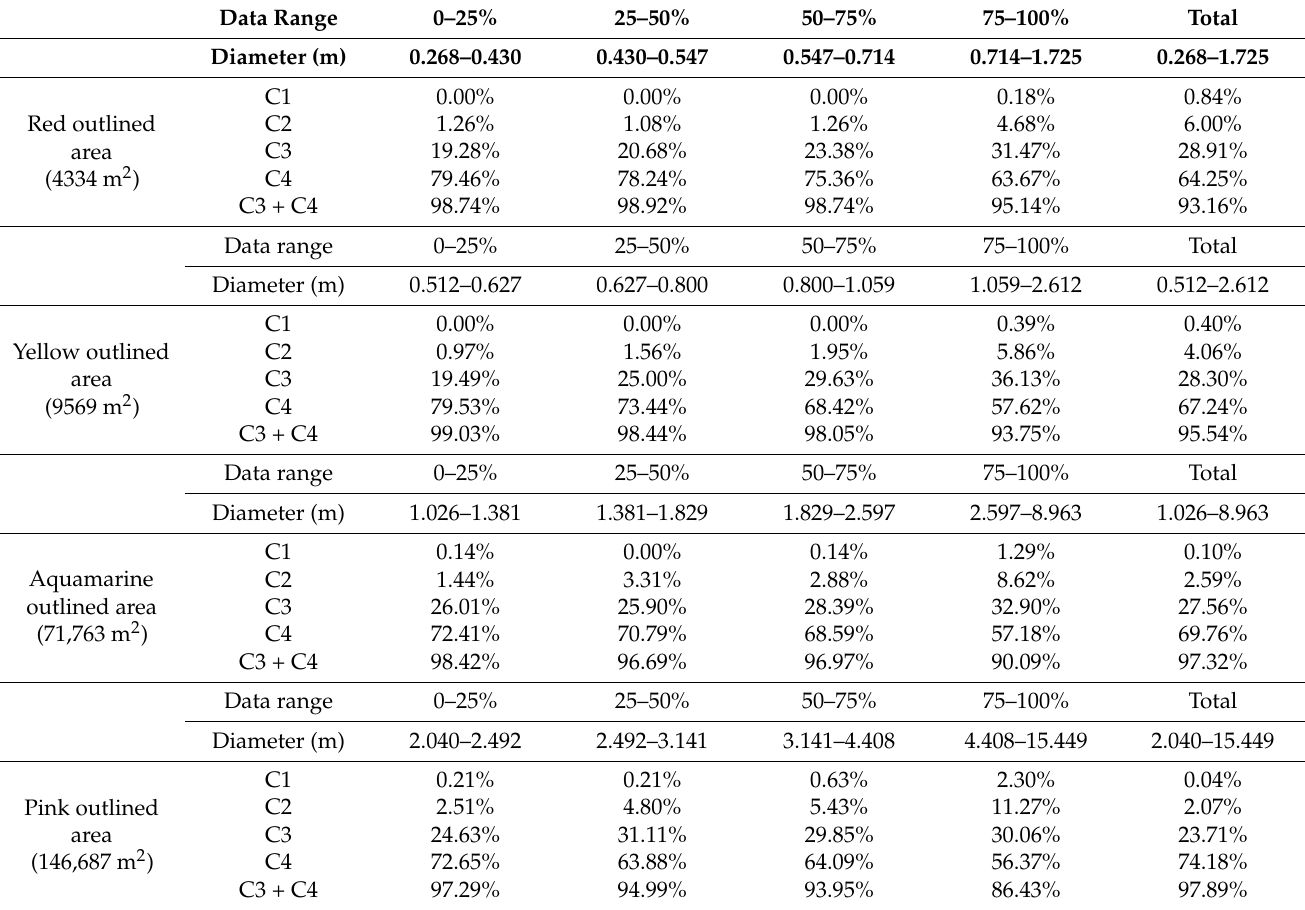
Table 1. Impact crater population diameter and degradation level statistics for the four study